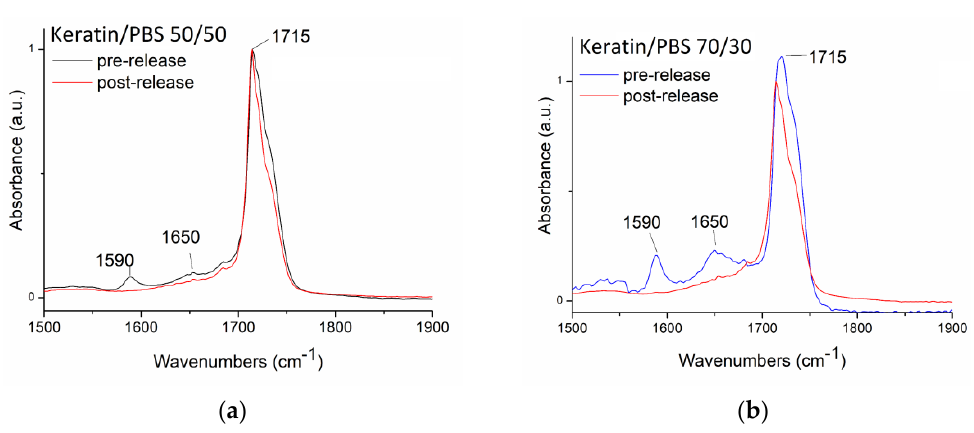
Figure 7. FTIR spectra of ( a ) Keratin/PBS 50/50 and ( b ) Keratin/PBS 70/30 pre and post release.